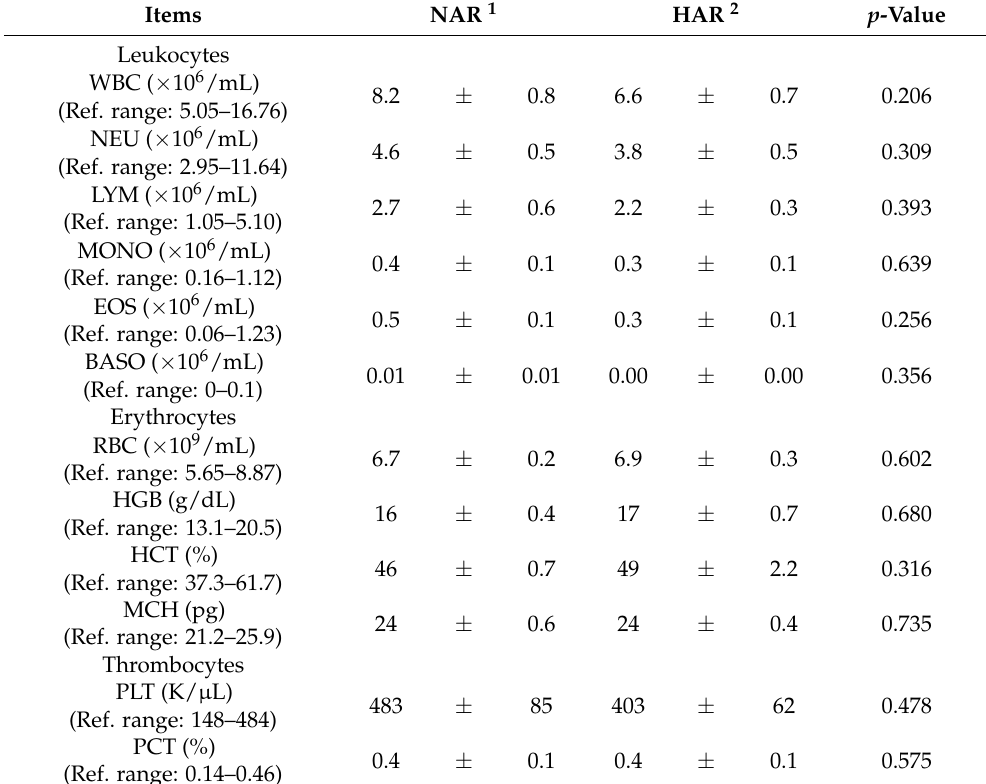
Table 7. Effects of high amylose type rice on hematological parameters in dogs (Exp.